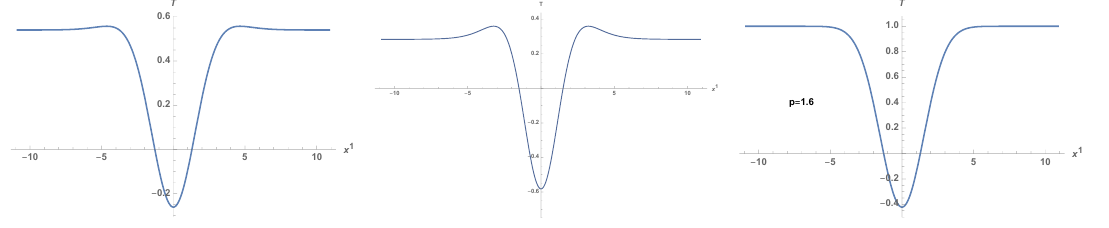
Figure 27 . Tachyon lump, left in Siegel gauge, center from [13], and right from the shifted 3-point